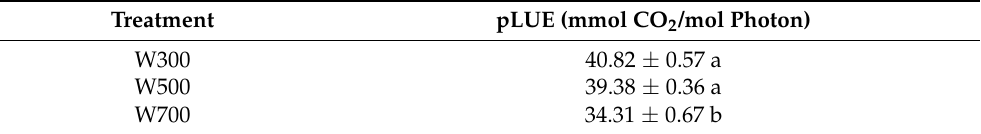
Table 3. Effect of PPFD on the photosynthetic light-use efficiency (pLUE) of leaves in ‘Micro-Tom’ 10 DAT in Experiment 1. pLUE is the ratio of net photosynthetic rate to PPFD (mmol CO 2 /mol photon). Each value represents the mean ± standard error. Different letters indicate significant differences among the treatments based on Tukey − Kramer’s test at p < 0.05 ( n = 4). W300, W500,